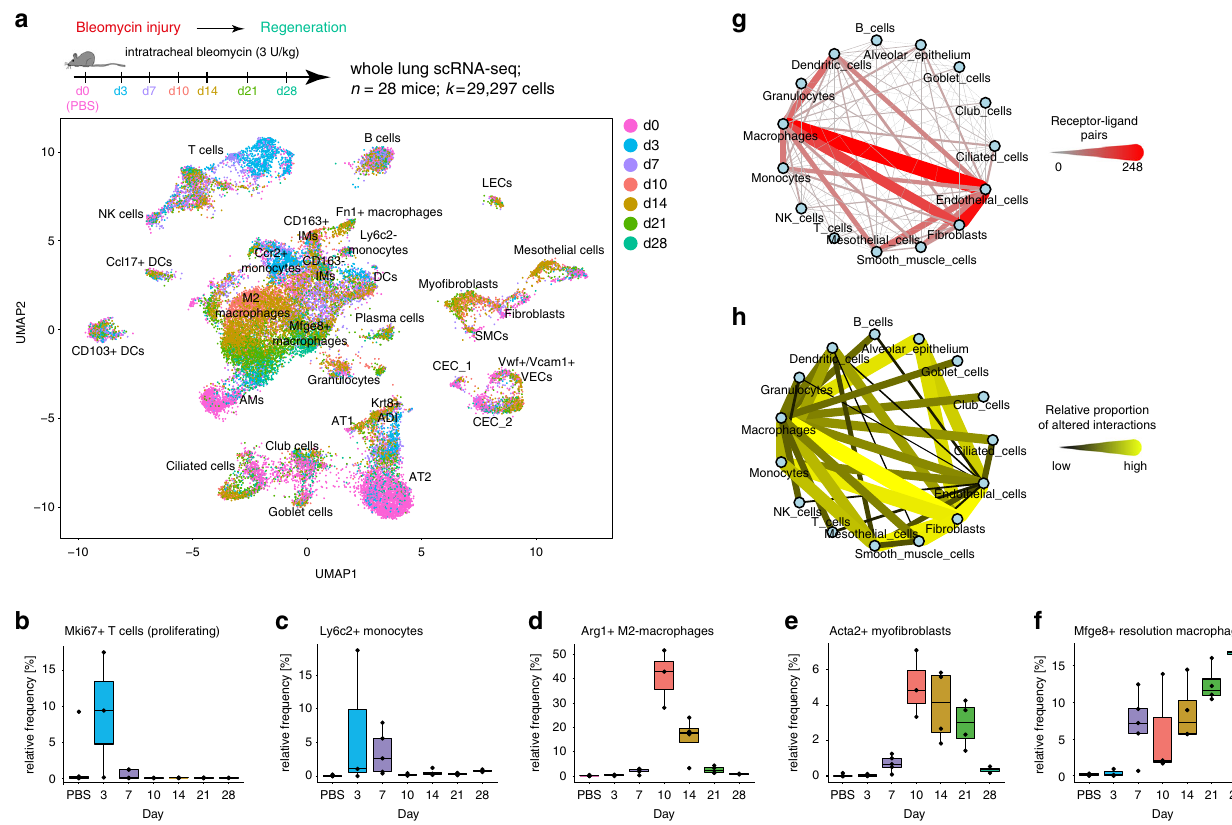
Fig. 1 Longitudinal single cell RNA-seq reveals cell state and cell communication dynamics. a Single cell suspensions from whole-mouse lungs were analyzed using scRNAseq at the indicated time points after bleomycin-mediated lung injury. The color code in the UMAP embedding shows shifts of the indicated cell types in gene expression space during the regeneration time course. b – f Relative frequency of the indicated cell types relative to all other cells was calculated for individual mice at the indicated time points after injury ( n = 4) and for PBS treated control mice ( n = 7). The boxes represent the interquartile range, the horizontal line in the box is the median, and the whiskers represent 1.5 times the interquartile range. g The network shows 15 meta- cell type identities (see Supplementary Fig. 1d) and their putative communication structure. Edge weight and color illustrate the number of receptor-ligand pairs between cell types. h The edges represent the relative proportion of receptor-ligand pairs between cell types with altered expression after